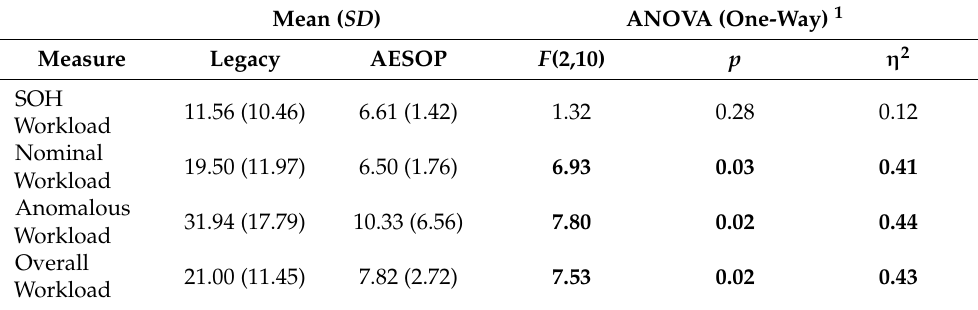
Table 5. Comparison of Workload across HMIs for Novice